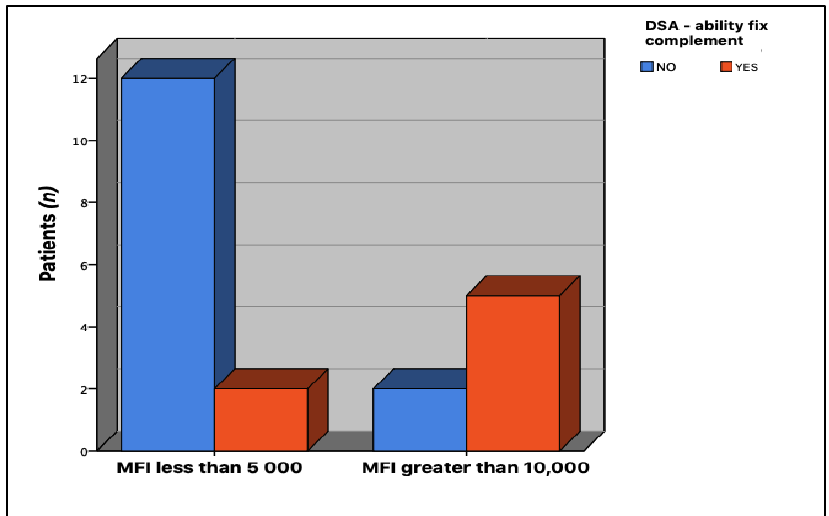
Figure 5. Association between MFI values and C1q binding capacity. Non-binding dnDSA comprise MFI values below 5000, whereas C1q-binding dnDSA are more related to MFI values above 10,000 ( p = 0.017).